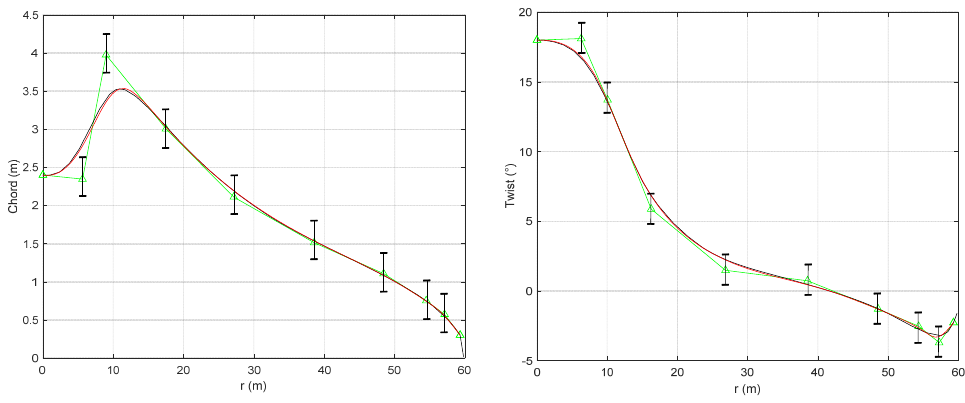
Figure 5. Chord and twist distributions of the blade.